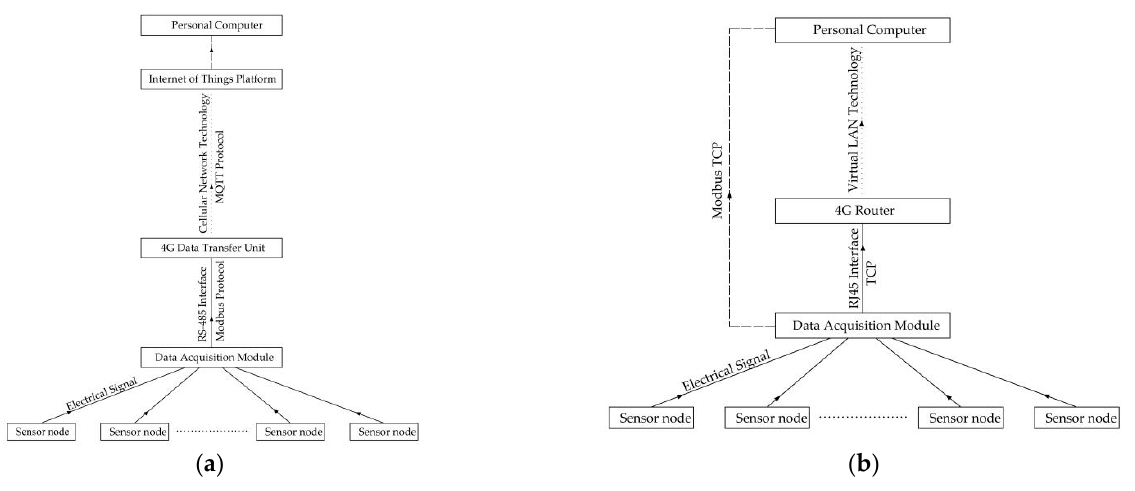
Figure 4. The frame structure of two data transmission methods. ( a ) Cellular Network technology data transmission structure; ( b ) Virtual LAN technology data transmission structure.